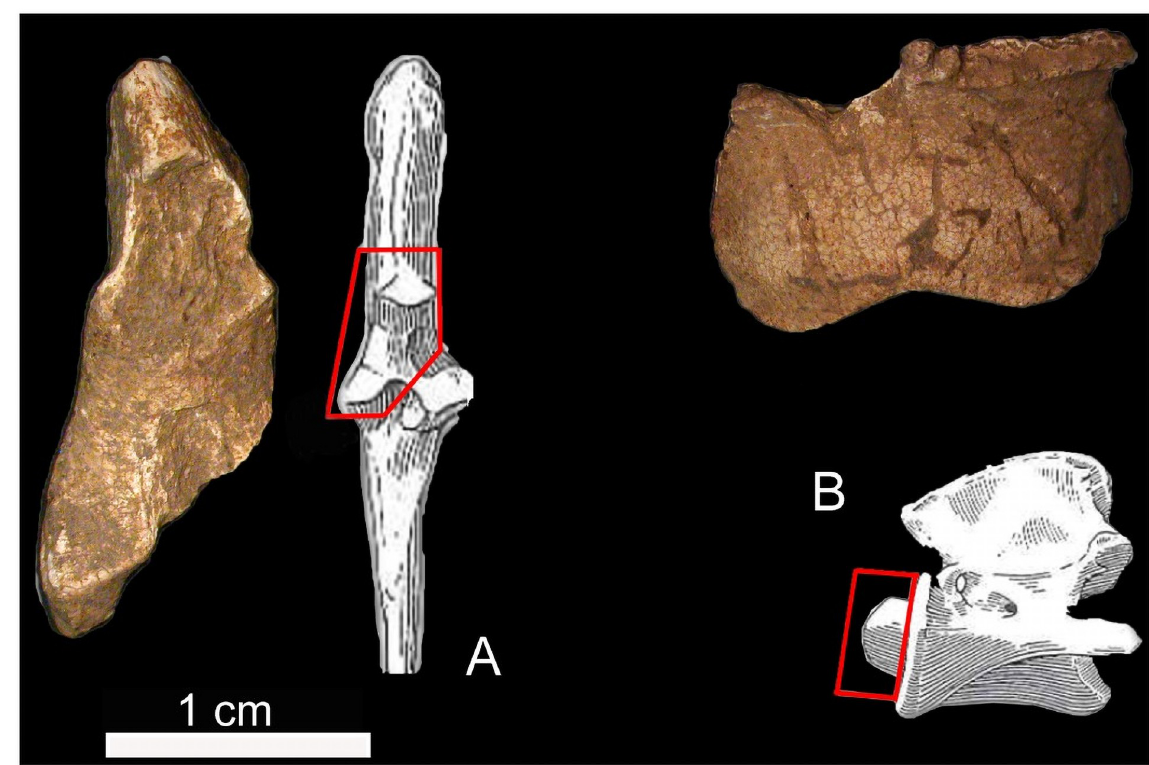
Fig 6. Faunal remains from the Tomb of Nestor’s Cup. cf. Ovis aries : Articular fragment of the left ulna (A) and odontoid process of the axis (B) with the fragments’ position on the anatomical reference element.